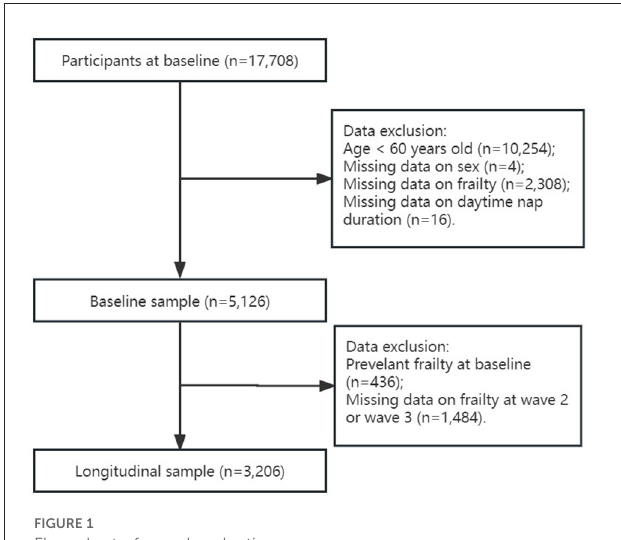
FIGURE1 Flow chart of sample